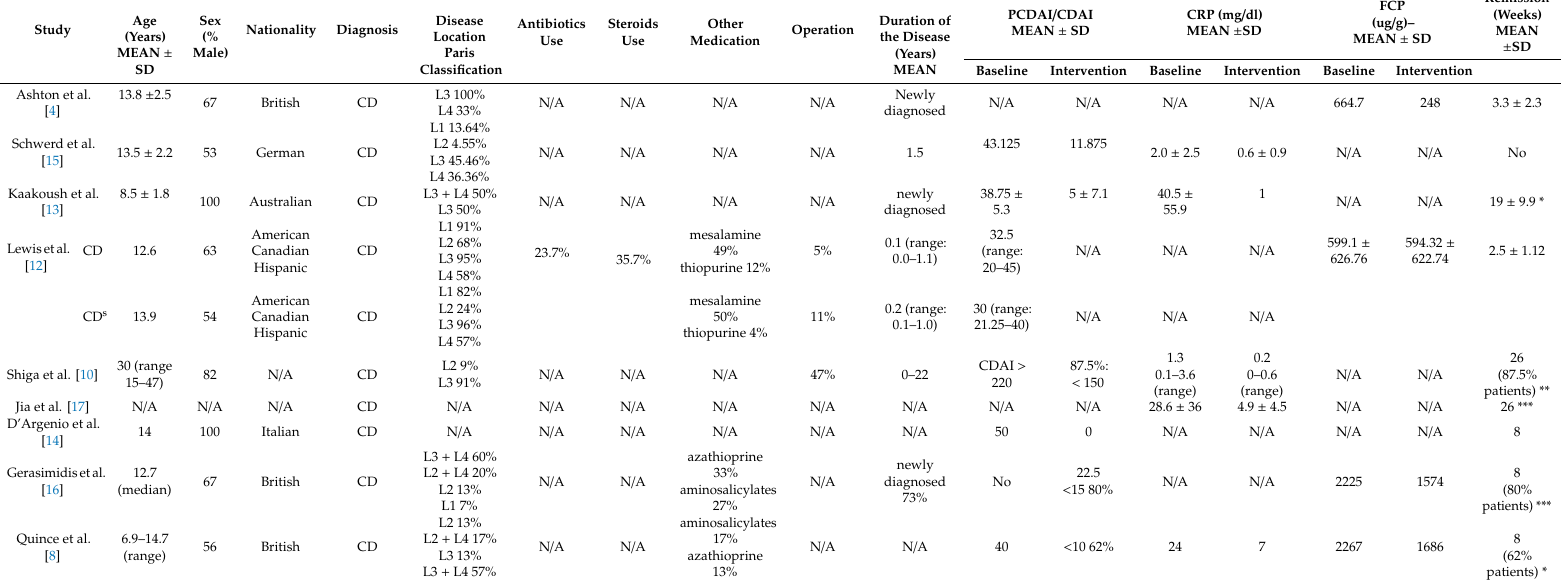
Table 2. Characteristics of the study population ( n =